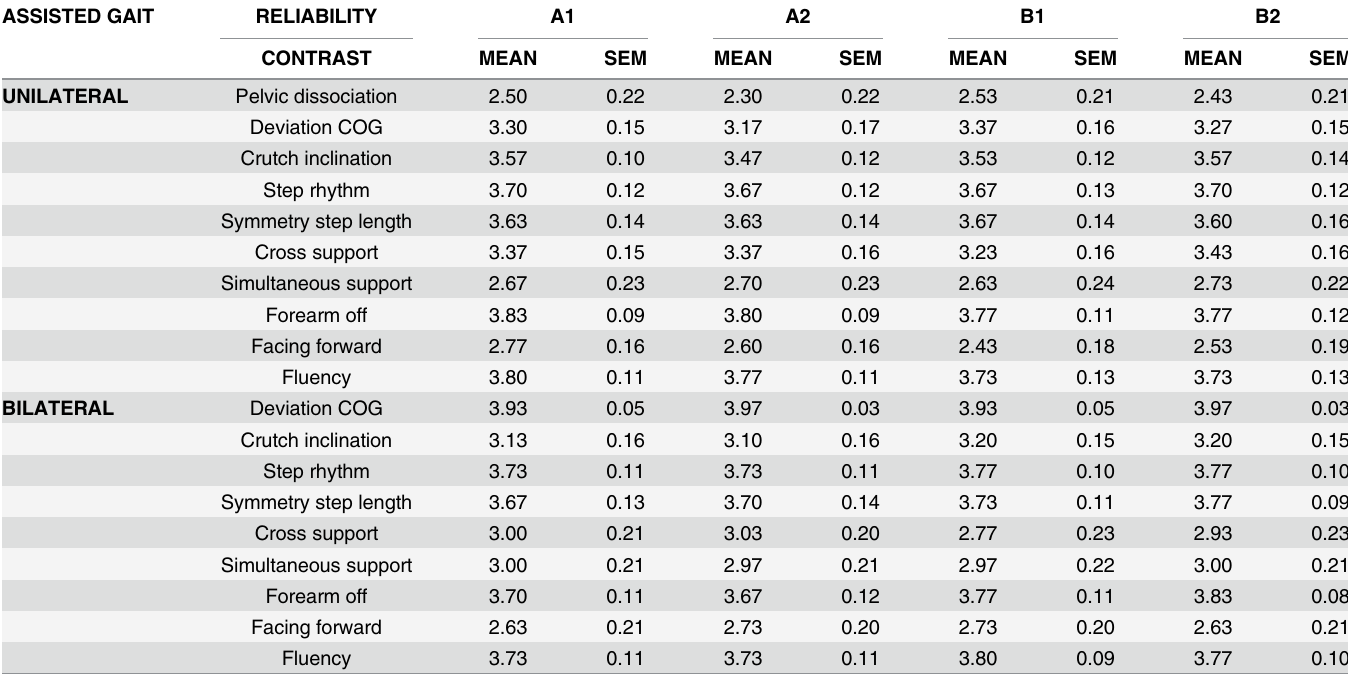
Table 4. SEM for each evaluator and observation. ASSISTED